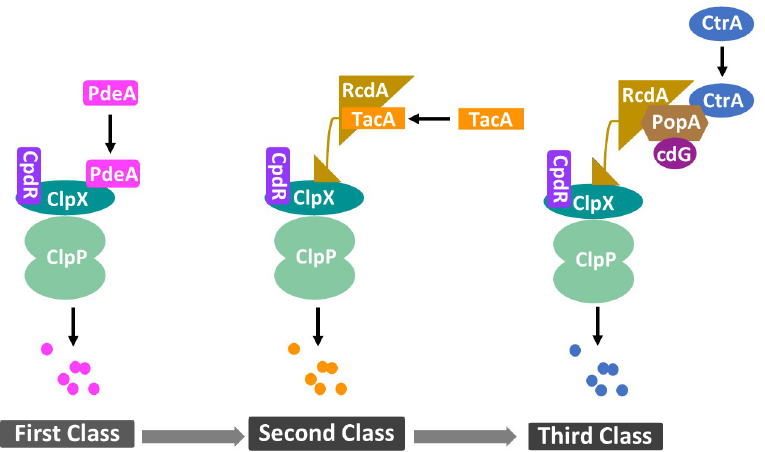
Fig 4. Hierarchical proteolysis of the first (eg. PdeA), second (eg. TacA), and third (eg. CtrA) substrate. The degradation of different substrates is dependent on the degree of adaptor assembly. Priming of the protease ClpXP by unphosphorylated CpdR results in PdeA decay, which recruits additional adaptor RcdA to degrade TacA. RcdA tethers cdG-bound PopA with primed ClpXP, which is responsible for the proteolysis of CtrA.